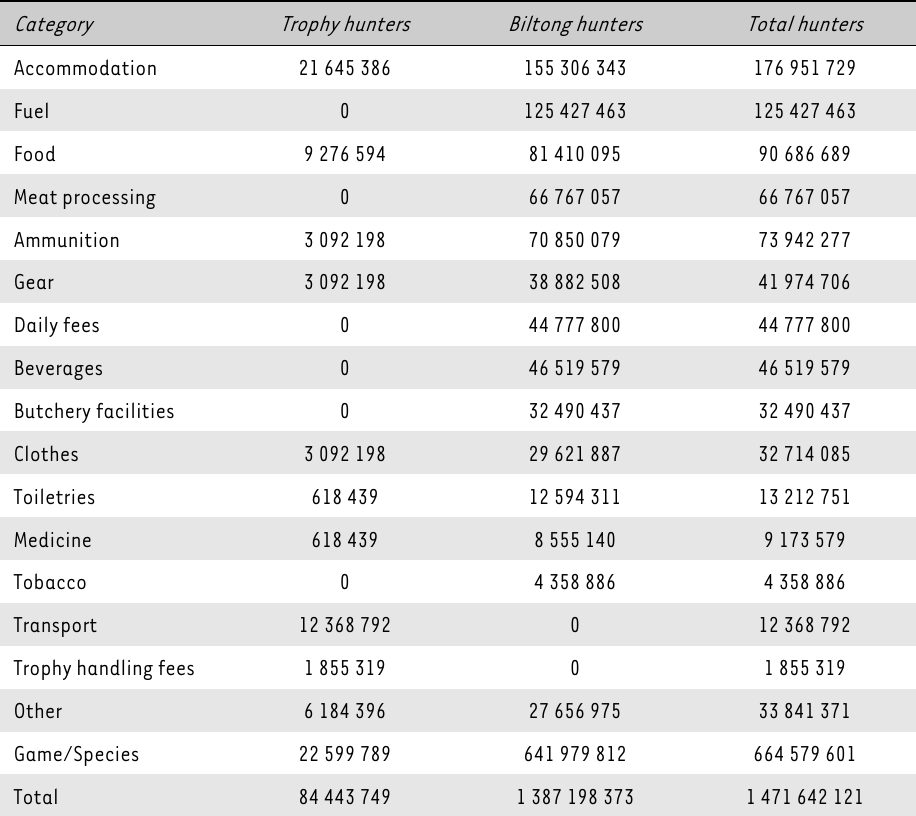
Expenditure directly related to hunting in 2010 (incl. game; ZAR, deflated to 2006 prices) Trophy